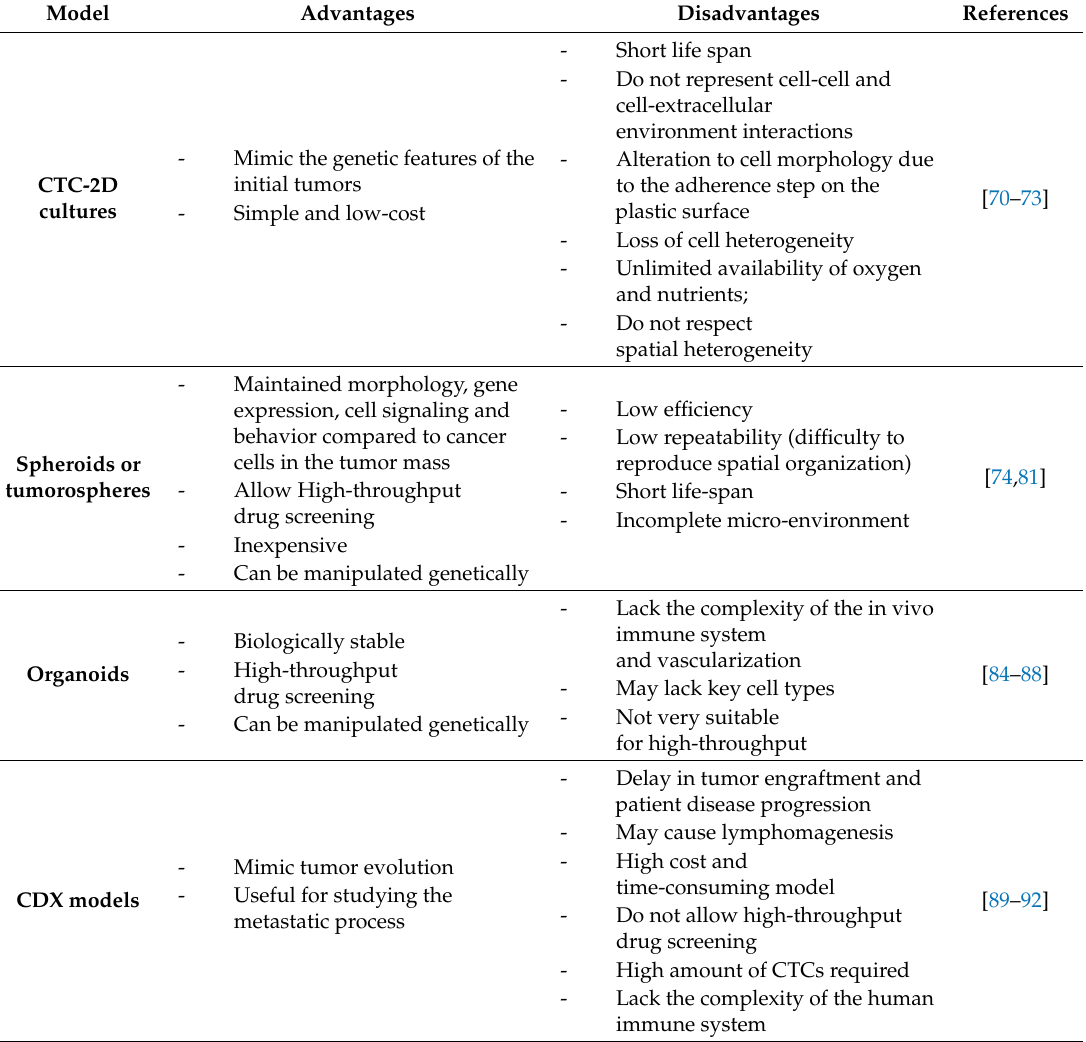
Table 1. In vitro and in vivo CTC-derived models. Advantages and